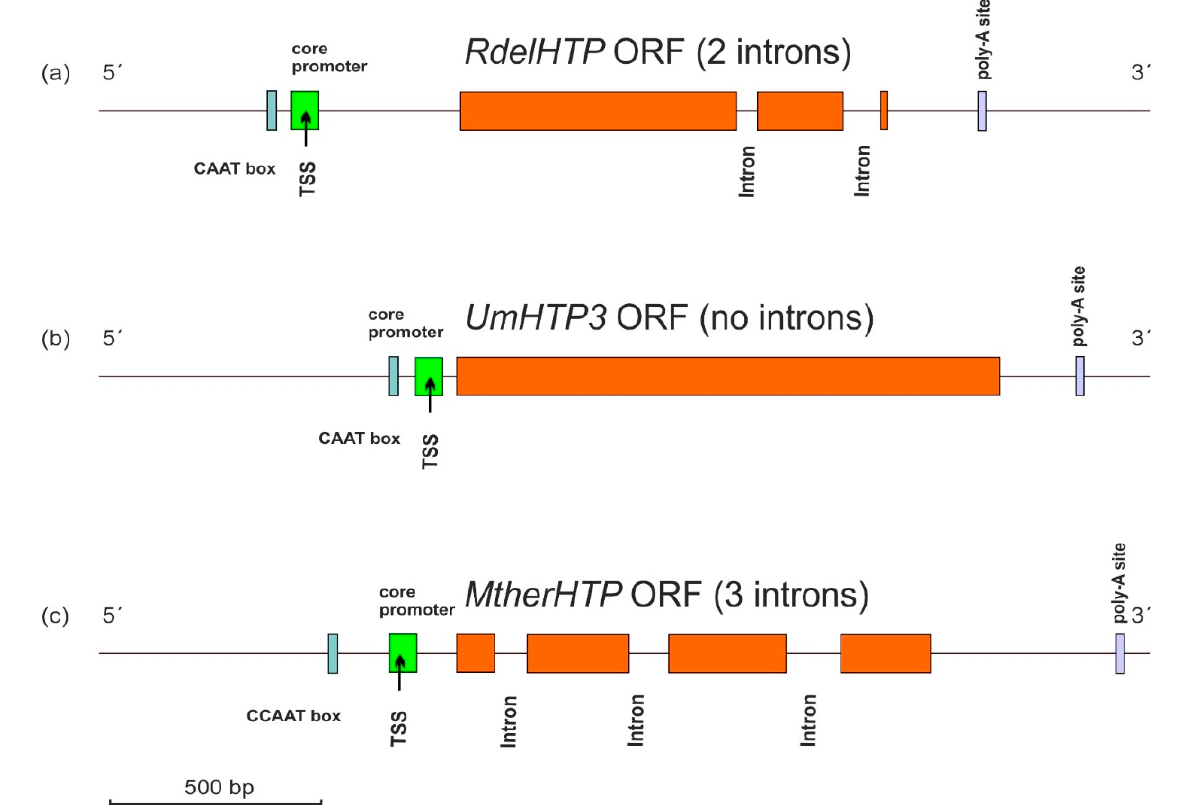
Figure 3. Typical gene architecture of ( a ) mucoromycetous, ( b ) basidiomycetous, and ( c ) ascomy- cetous HTP gene with detection of the core promoter region (labelled green), CCAAT box (cyan), and poly-A site (violet). TSS—transcription start site. Orange—HTP coding regions. The distribu- tion of introns and position of regulatory elements is drawn to scale according to predictions